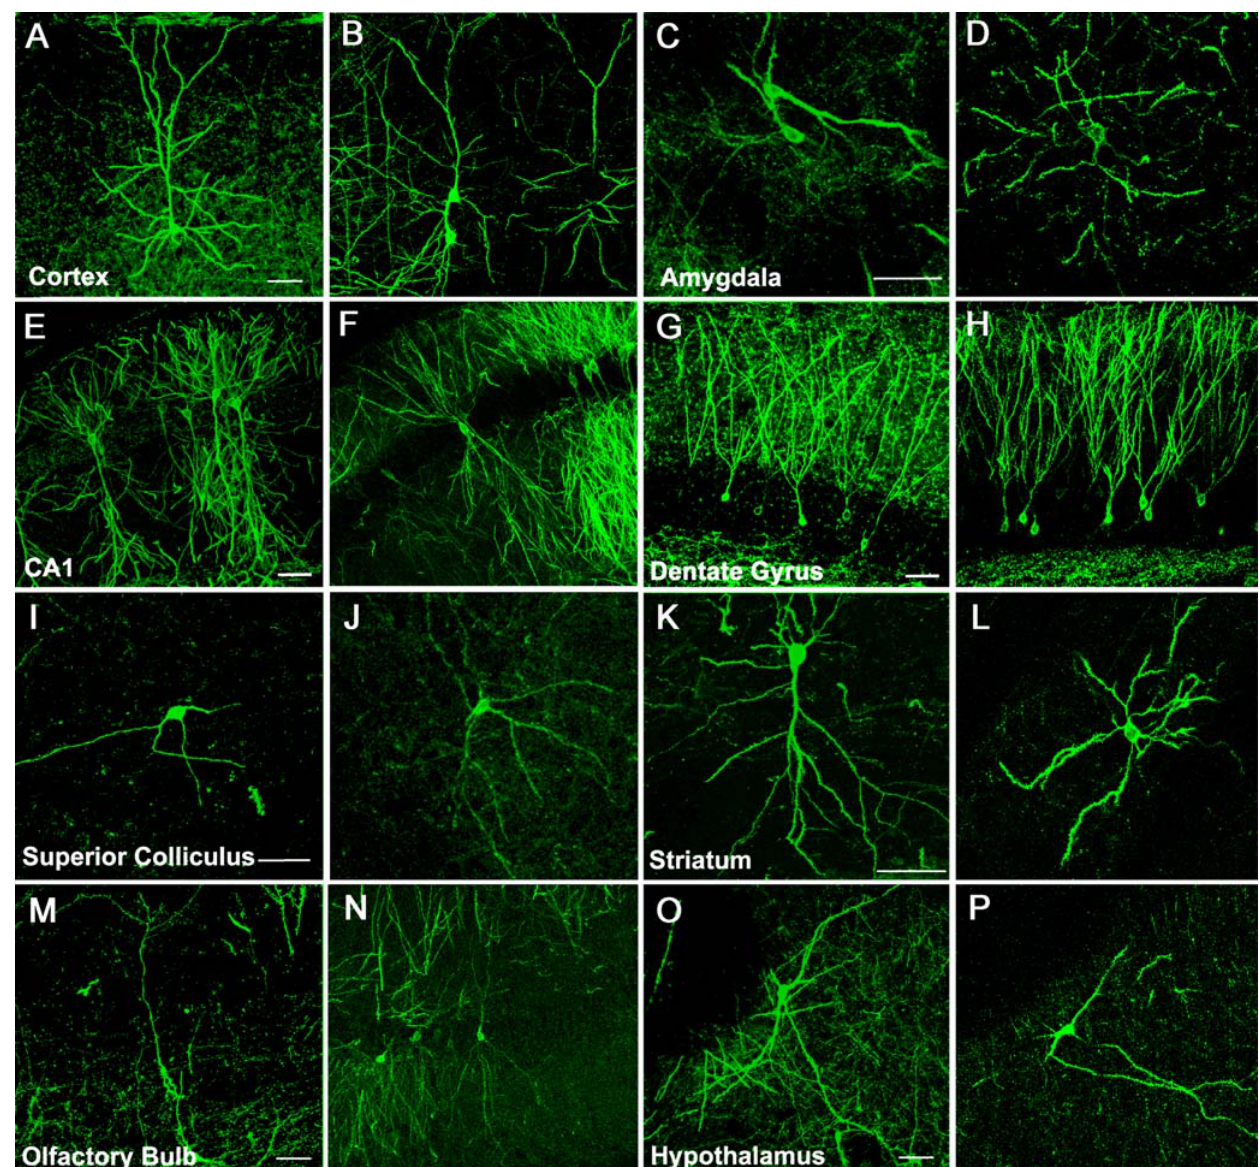
Figure 4. Cre-dependent EGFP-F labels distinct neuronal types in the adult forebrain. Confocal microscopy images showing that mosaic EGFP-F expression in a 2 month old TLG 498 + Cre 3487 + mouse occurs in pyramidal cells in (A) neocortex, (C) amygdala and (E) hippocampal CA1; (G) granule cells in the dentate gyrus; (I) marginal cells in the superior colliculus; (K) spiny projection neurons in the striatum; (M) granule cells in the olfactory bulb and (O) tubero-mammillary cells in the posterior hypothalamus. Scale bar 2 50 m m.Mosaic EGFP-F expression in a 2 K month old TLG 1157 + Cre 3487 + transgenic mouse occurs in the same cell types as shown by the juxtaposed figures (B, D, F, H, J, L, N, P – same scale as juxtaposed